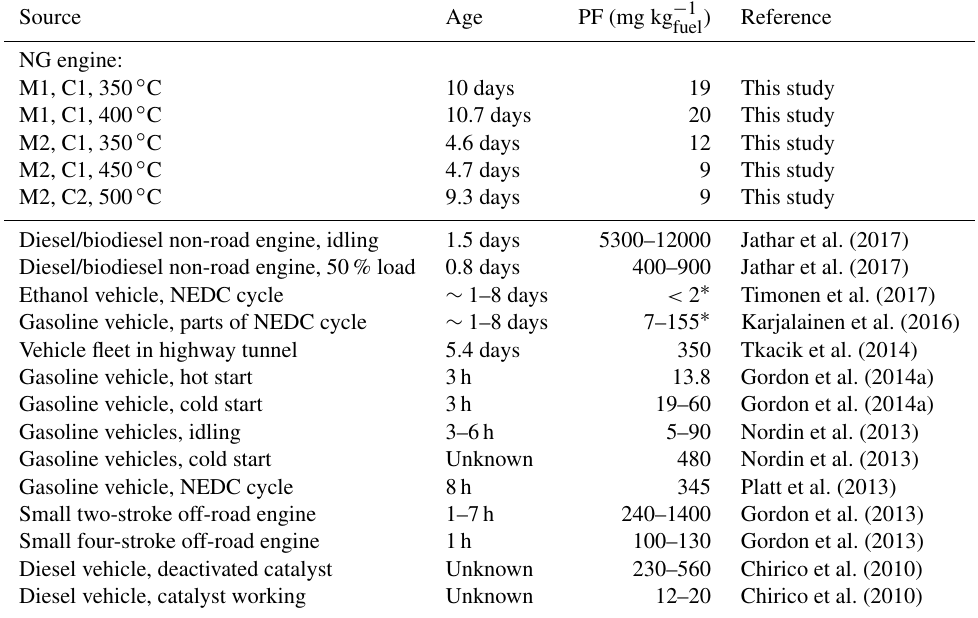
Table 2. SOA production factors calculated from the SP-AMS data in this study and in literature (age is OH exposure / (1 . 5 × 10 6 moleccm − 3 )). Primary organic aerosol has been subtracted from the total aged organic